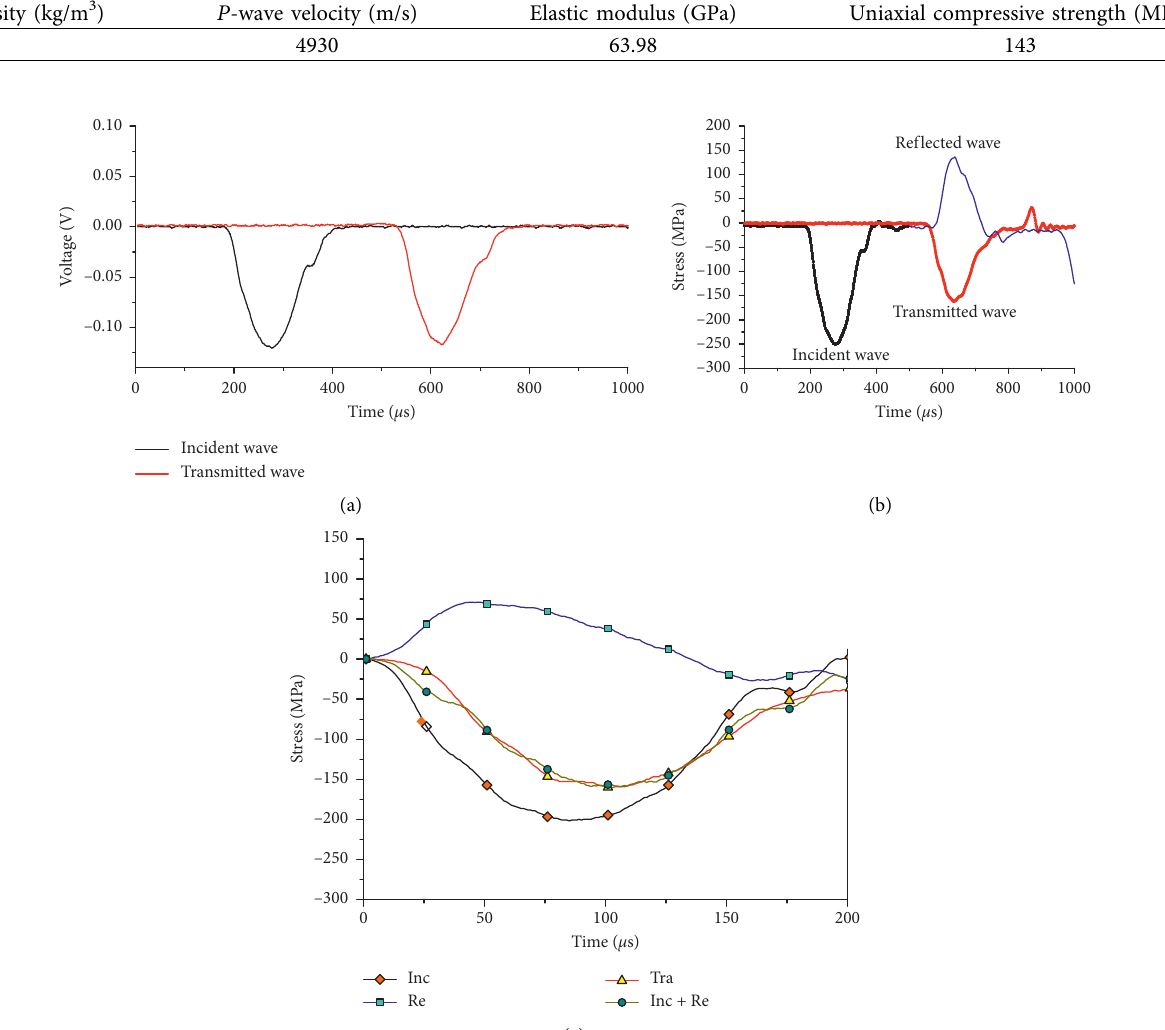
Table 1: Mechanical parameters of granite under static load.